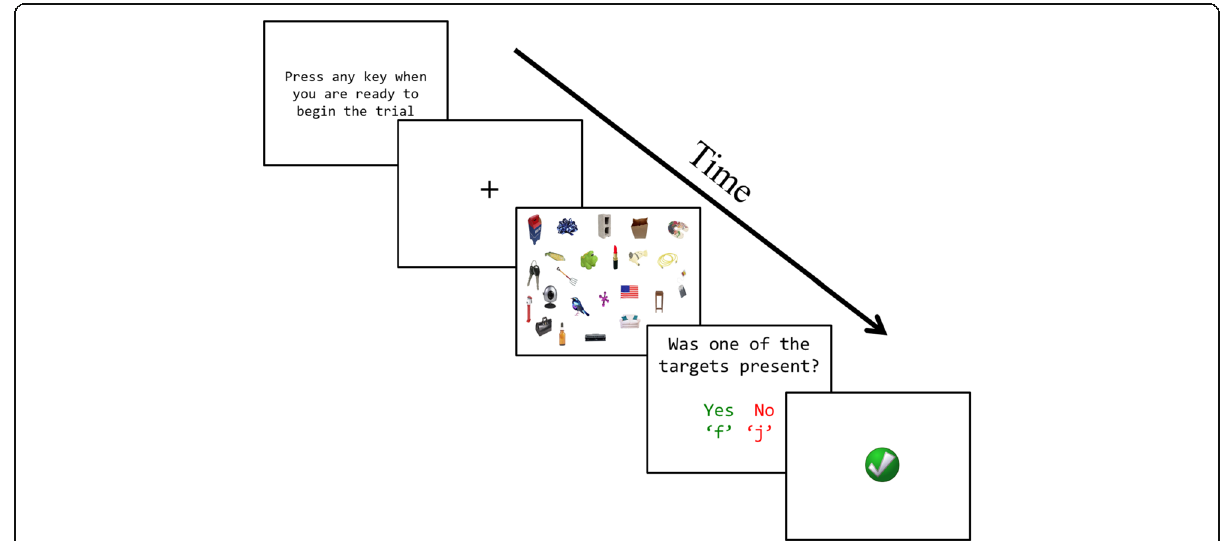
Fig. 2 Timeline showing the progression of events in a visual search